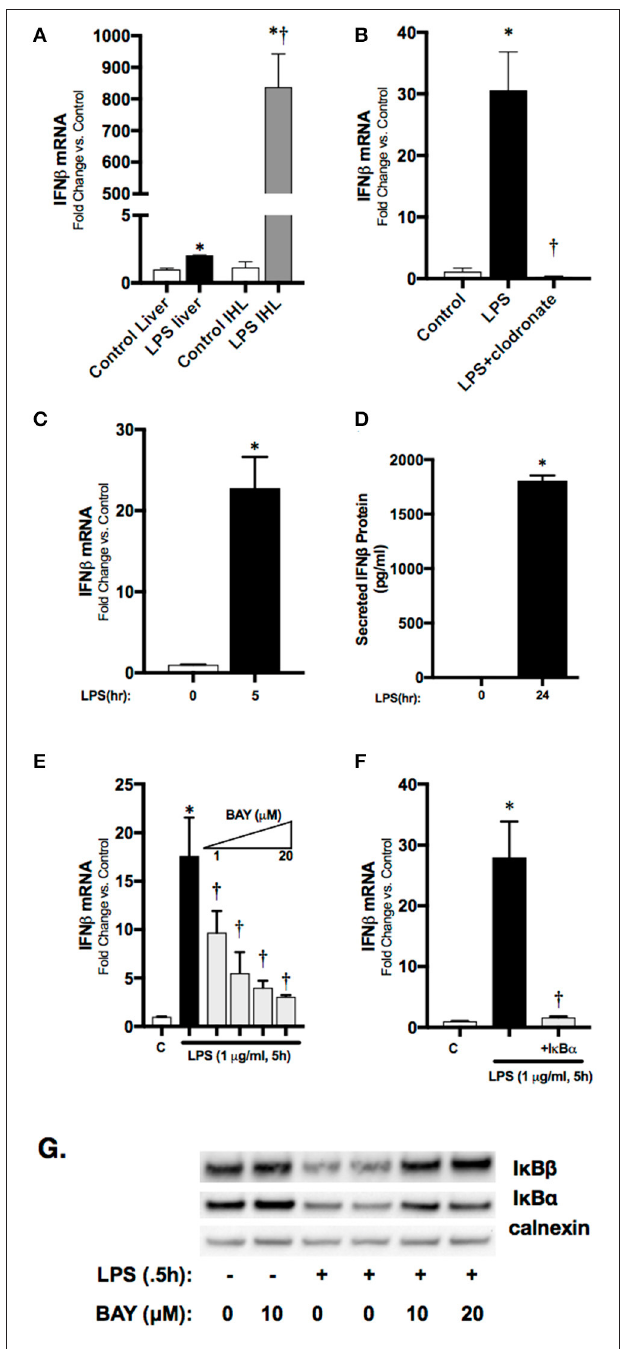
FIGURE 3 | Macrophage-derived, LPS-induced IFN β stimulates STAT1 activation in vitro . (A) Fold-increase in gene expression of IFN β in adult whole liver or isolated intrahepatic leukocytes following LPS exposure (2h, 50 mg/kg). * p < 0.05 vs. control; † p < 0.05 vs. LPS-exposed whole liver. Values shown as means ± SEM; n = 4–6/timepoint. (B) Fold-increase in gene expression of IFN β in adult liver following LPS exposure or clodronate pretreatment (24h) with LPS exposure (4h, 3 mg/kg). * p < 0.05 vs. control; † p < 0.05 vs. LPS-exposed. Values shown as means ± SEM; n = 4–6/timepoint (C) Fold-increase in gene expression of IFN β in RAW 264.7 macrophages following LPS exposure (0–5h, 1 µ g/ml).